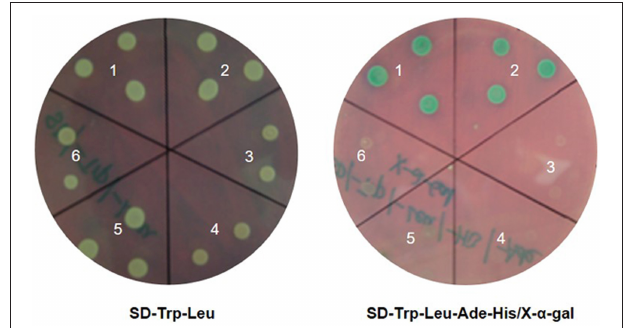
FIGURE 4 | Yeast two-hybrid assays of full-length MdATG8i and MdATG7s proteins. For testing protein–protein interactions, transformed yeast cells were grown on selective SD medium lacking Trp and Leu (Left) or SD medium lacking Trp, Leu, Ade, and His nutrients (Right). Empty